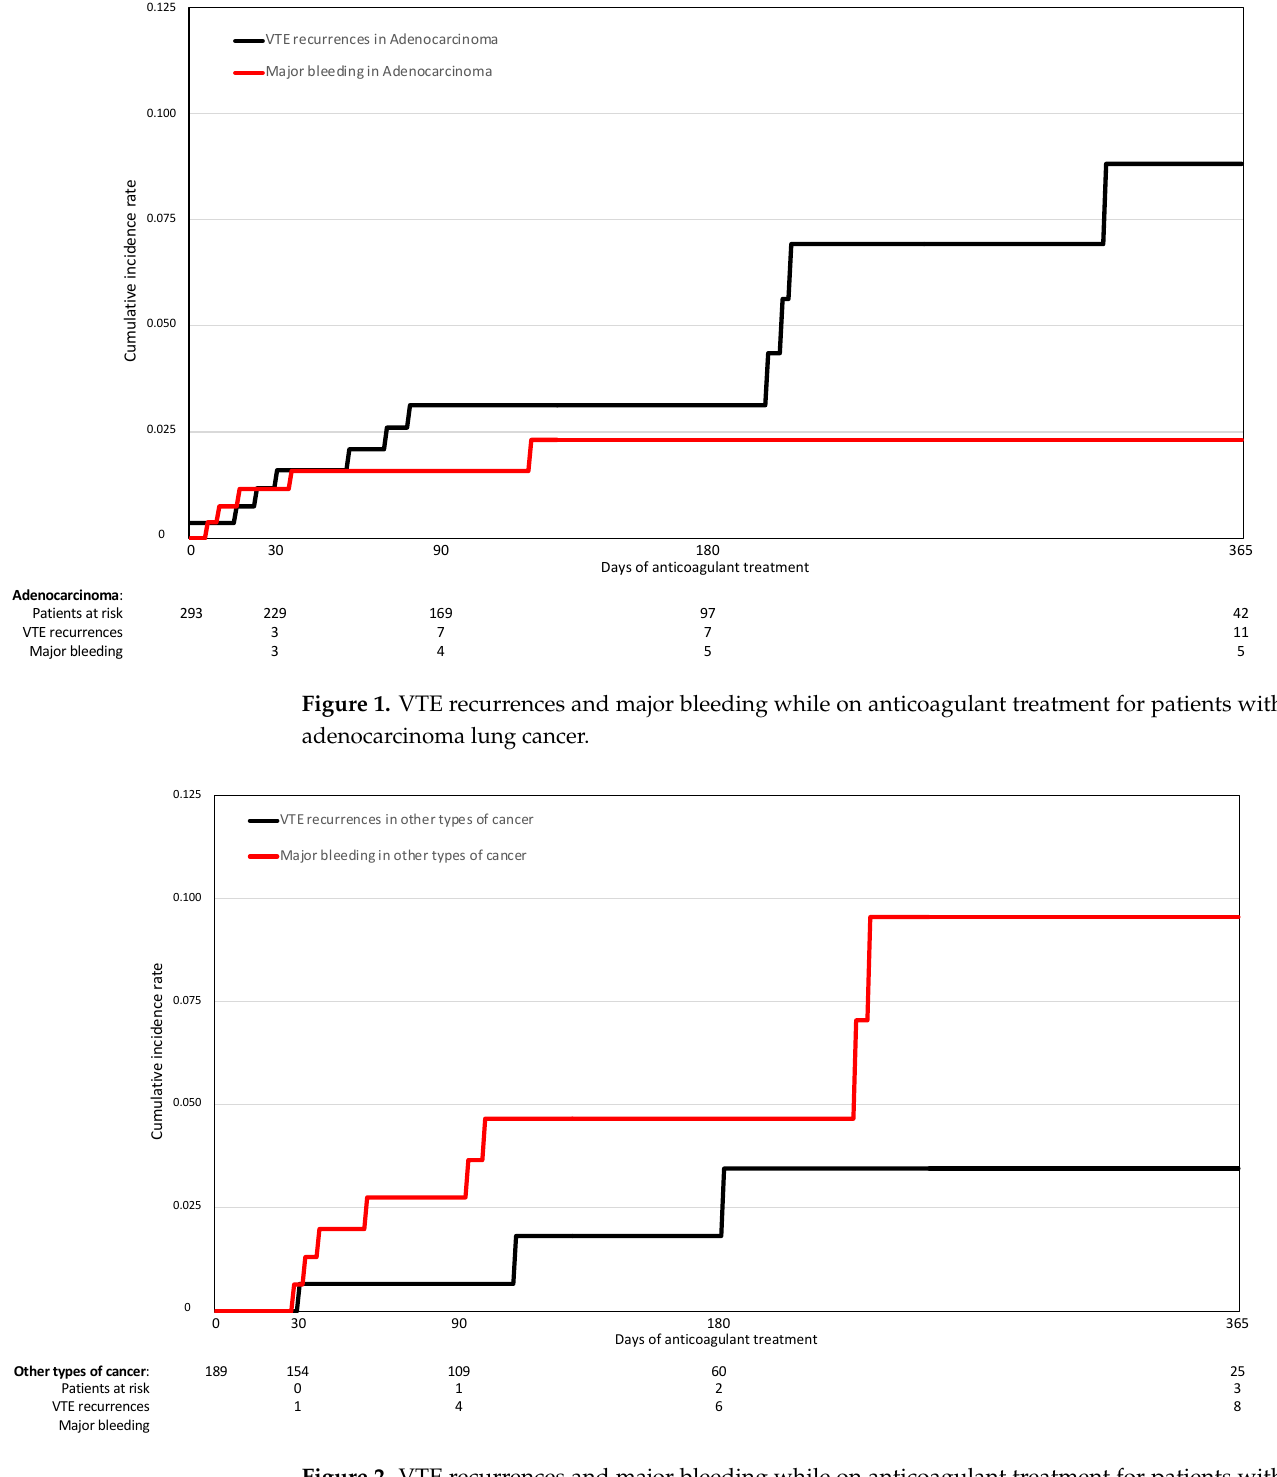
Figure 2. VTE recurrences and major bleeding while on anticoagulant treatment for patients with other types of lung